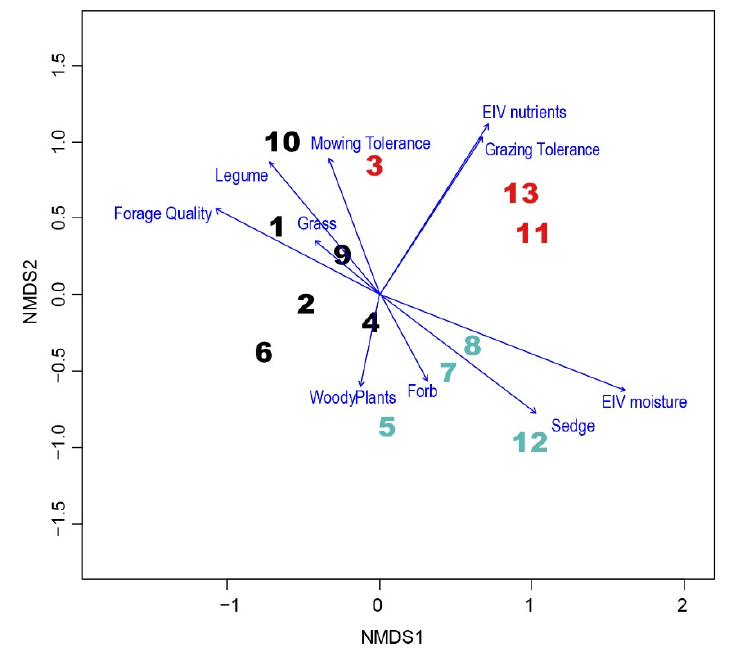
Figure 2. Ordination diagram of non-metric multidimensional scaling (NMDS) of vegetation plots with passively projected forage quality, growth forms, tolerance to mowing and grazing, EIV Moisture, and EIV Nutrient. NMDS stress is 0.2027. Legend: 1—semi-dry meadows ( Salvio nemorosae-Arrhenatherion ); 2—mesic meadows ( Arrhenatherion ); 3—mesic pastures ( Cynosurion ); 4—mesic to wet meadows in the western part of the area ( Alopecurion ); 5—wet oligotrophic meadows ( Molinion ); 6—